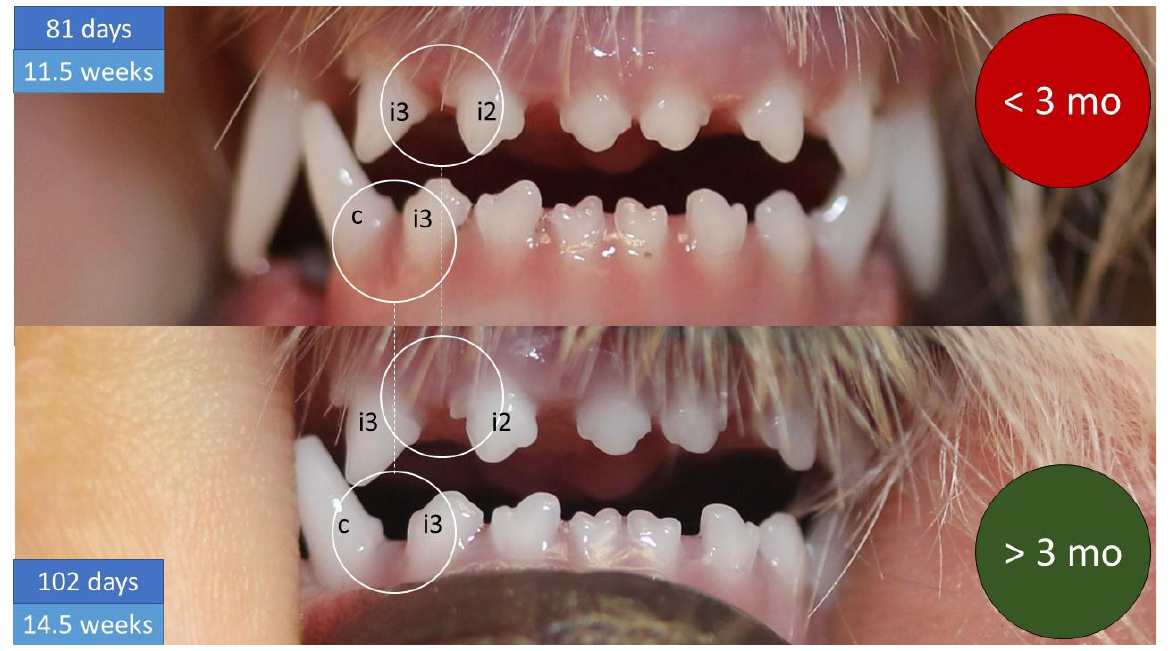
Figure 12. The gaps between the teeth of dogs under and over three months of age show a characteristic (about twofold) difference.